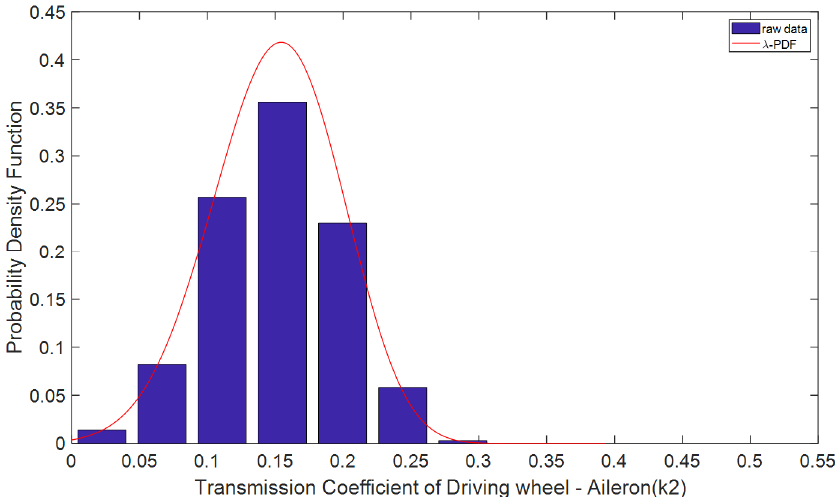
Figure 6. PDF of transmission coefficients from steering wheel to aileron.